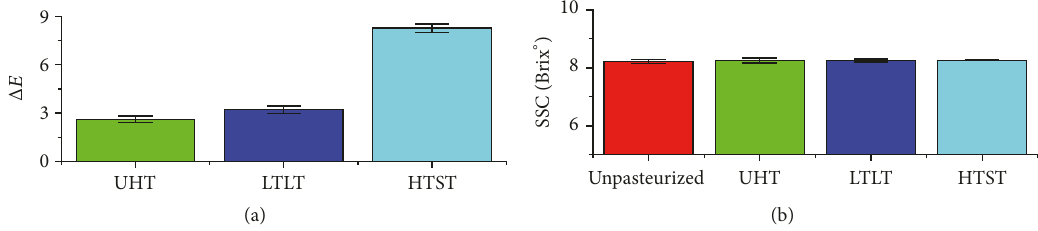
Figure 2: Effect of thermal treatments on the color (a) and soluble solid content (b) of the watermelon juice. UHT: ultrahigh temperature; LTLT: low temperature long time; HTST: high temperature short